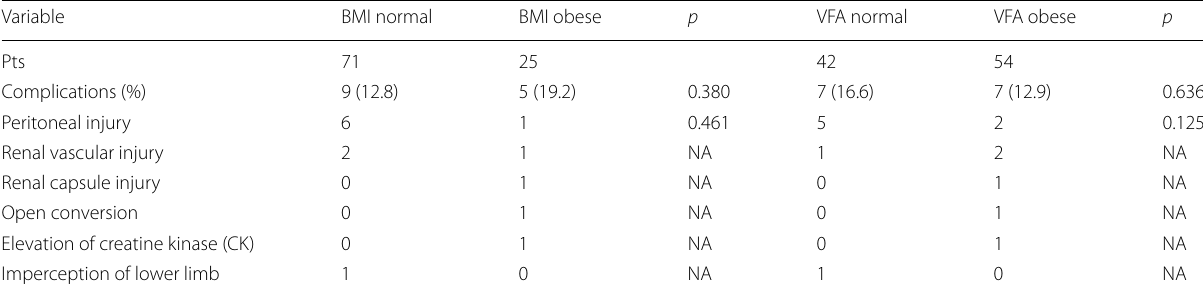
Data are presented as cases